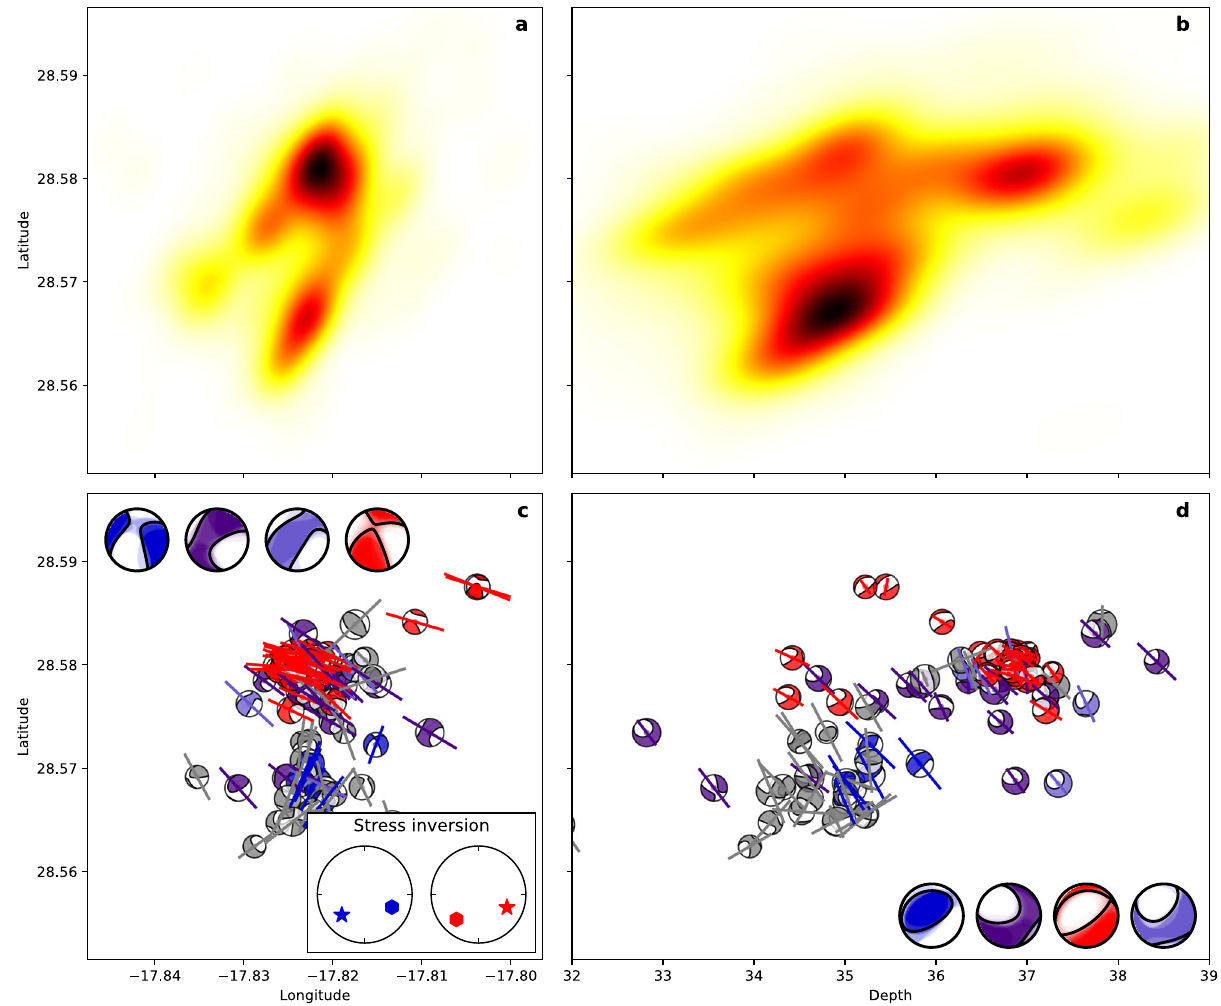
Fig. 5 | Seismicity distribution at the deep cluster. a Normalised density of relocated hypocentres (darker regions corresponding to higher density) in map view and b vertically by latitude . c Moment tensor solutions (small focal spheres) for the moment tensor catalogue as in Fig. 4; the larger families are identi fi ed in